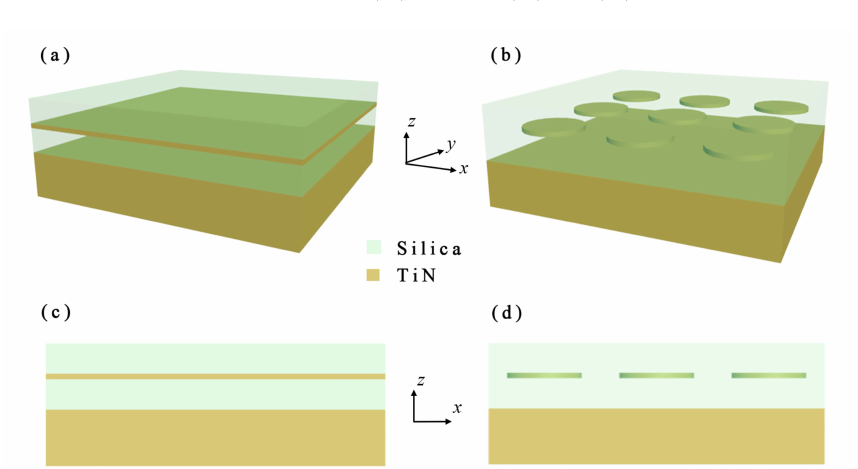
Figure 1. Schematics of proposed MPA consisting of SiO 2 /TiN/SiO 2 /TiN stacks: ( a ) perspective view; and ( c ) front-view. Schematics of proposed MPA consisting of SiO 2 /TiN-disk-array/SiO 2 /TiN stacks: ( b ) perspective view; and ( d )